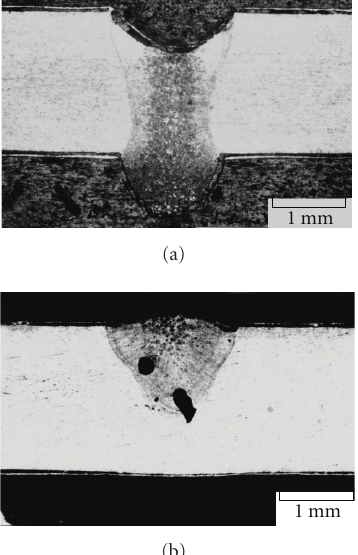
Figure 8: Fusion zone configuration of alloy AA5083 made using P = 4kW, S = 6m/min. (a) Dd = − 1 . 5 mm, (b) Dd = −